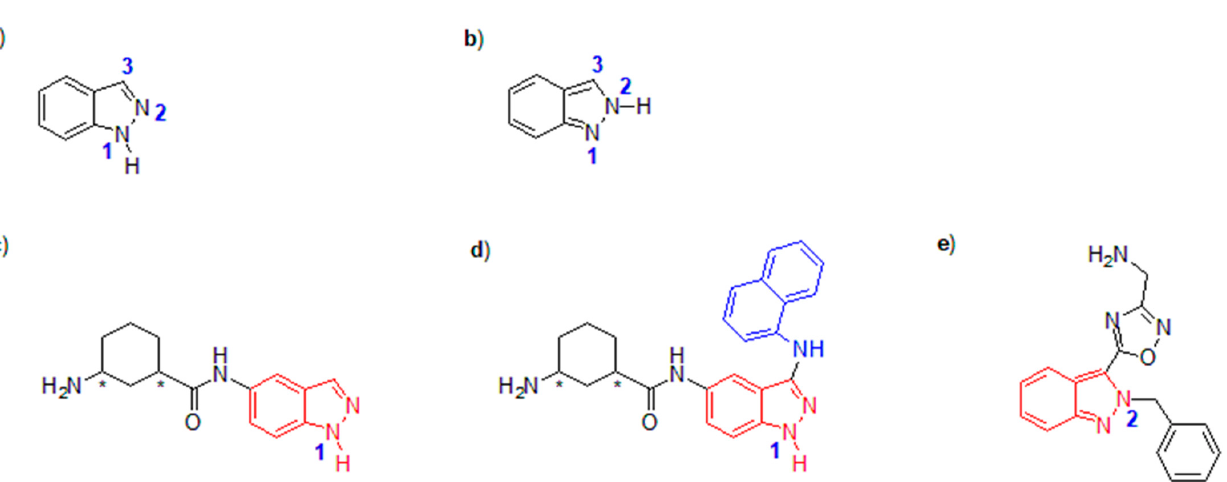
Figure 1. The tautomers of indazole, as well as 1 H - and 2 H -indazoles-derived potential pharmaceu- ticals: ( a ) 1 H -indazole; ( b ) 2 H -indazole; ( c ) SR-17398 (anticancer), ULK1 inhibitor IC 50 = 22.4 μ mol L − 1 , * mixture of 4 stereoisomers; ( d ) SR-17398 derivative (anticancer), ULK1 inhibitor IC 50 = 45 n mol L − 1 , * mixture of 4 stereoisomers; ( e ) Neuroprotective sodium channel modulator.